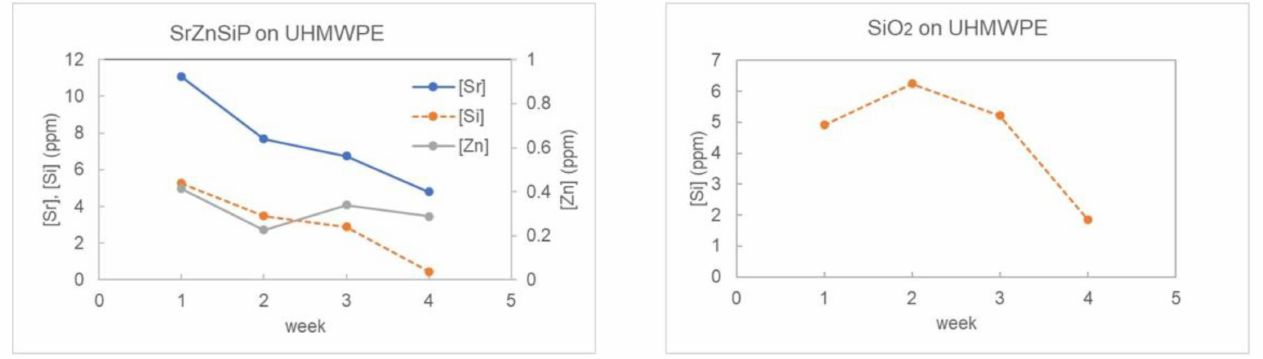
Figure 13. Variations in the concentrations of various ions released from ( a ) SrZnSiP coating and ( b ) SiO 2 coating during immersion in water for four